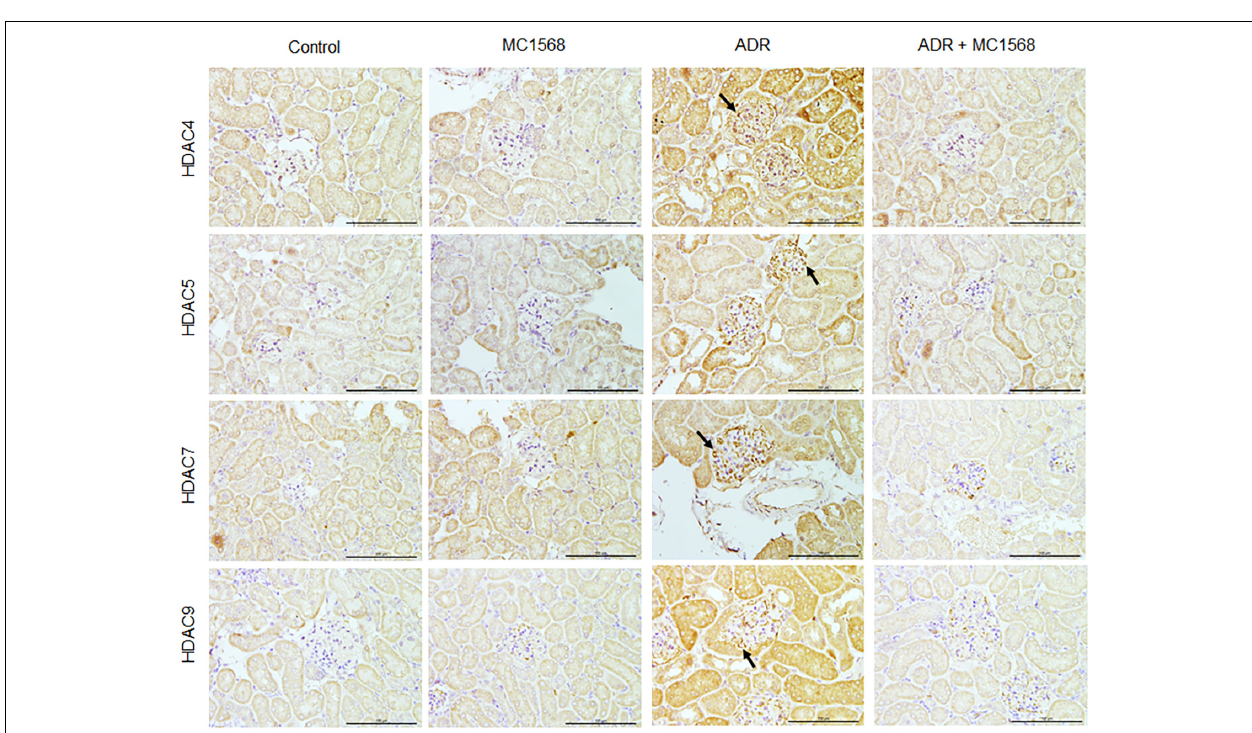
FIGURE 5 | MC1568 administration ameliorates proteinuria and kidney function. (A) Urinary albumin/creatinine ratio in control and ADR-injected mice treated with or without MC1568. Statistical analysis was performed with two-way ANOVA. ∗∗ p < 0.01. (B) Representative PAS stained kidney images, black arrows indicate the glomerulosclerosis. Scale bar, 40 µ m. (C) Representative transmission electron microscopy images, red arrows indicate the foot process effacement. Scale bar, 2 µ m.